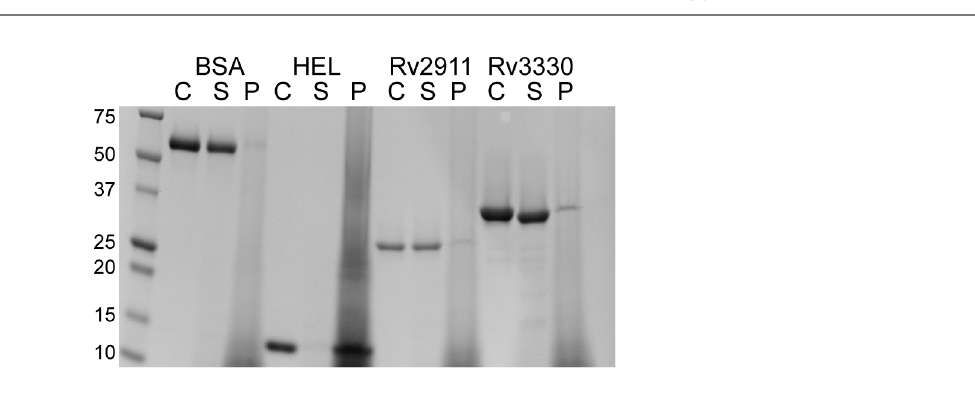
Fig. 4. Rv2911 and Rv3330 catalytic domains bind weakly to peptidoglycan in vitro . SDS-PAGE of control (C), supernatant (S), and peptidoglycan fractions (P) following pull-down with B. subtilis peptidoglycan. Hen egg lysozyme (HEL) and bovine serum albumin (BSA) were used as positive and negative controls, respectively. The left lane contains molecular marker in kDa